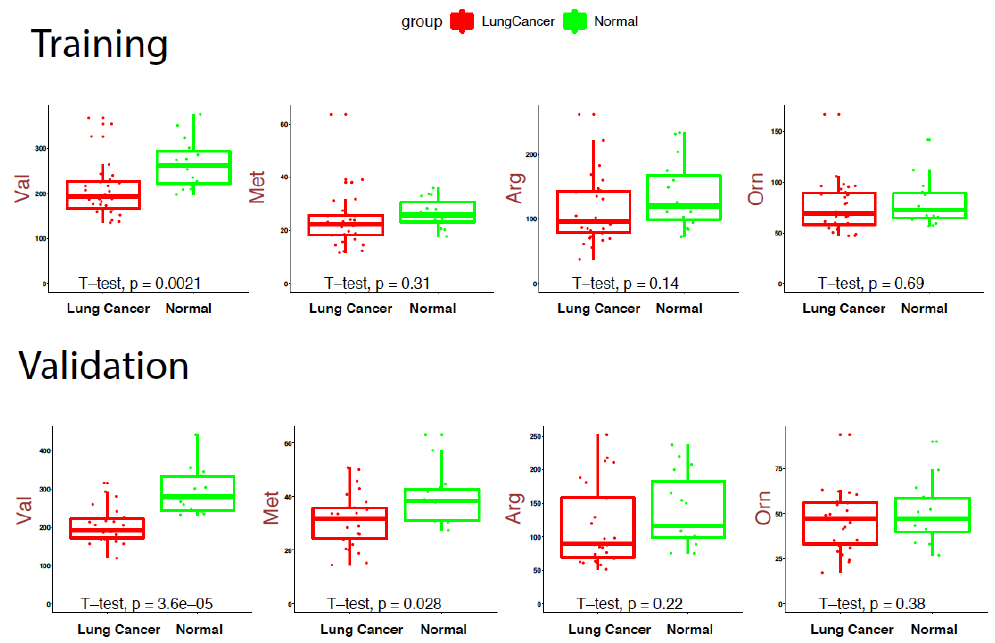
Figure 4. Box plots under training data and validation datasets. X axis represents disease status; Y axis represents metabolite concentrations of corresponding metabolite. Val: Valine; Met: Methionine; Arg: Arginine, Org: Ornithine. Supplementary Materials Figure S1 provides the full range of the Box Plots.